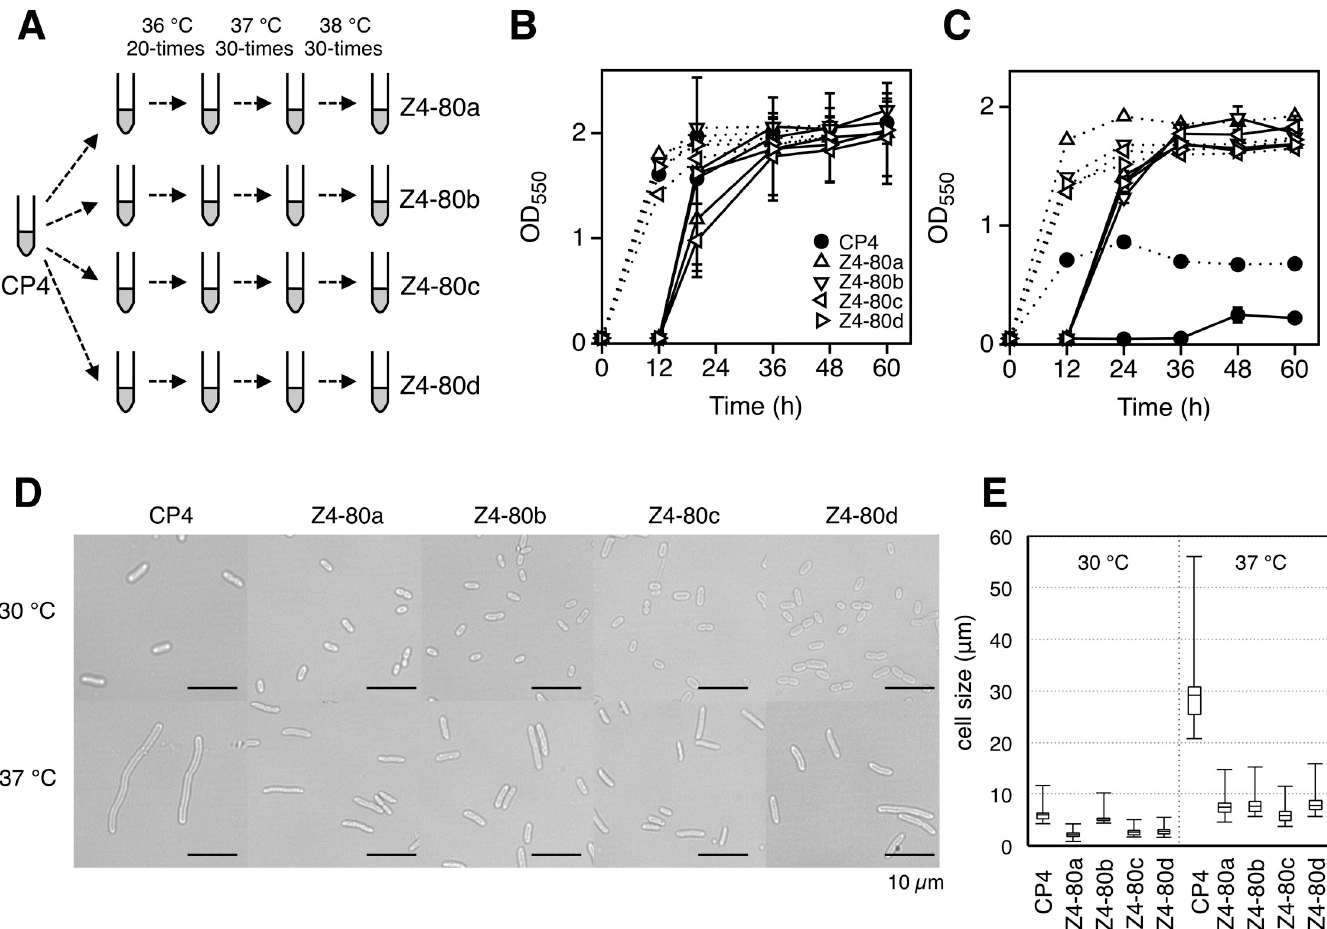
Fig 2. Thermal adaptation of Z . moblis CP4 and characteristics of thermoadapted mutants. (A) Z . moblis CP4 was thermally adapted in 4 lines as depicted, and detailed description is given in the text and the methods section. (B and C) Two-step cultivation of 4 thermoadapted mutants was performed at 30˚C (B) and 39˚C (C). (D and E) Their cell morphology (D) and cell size (E) were